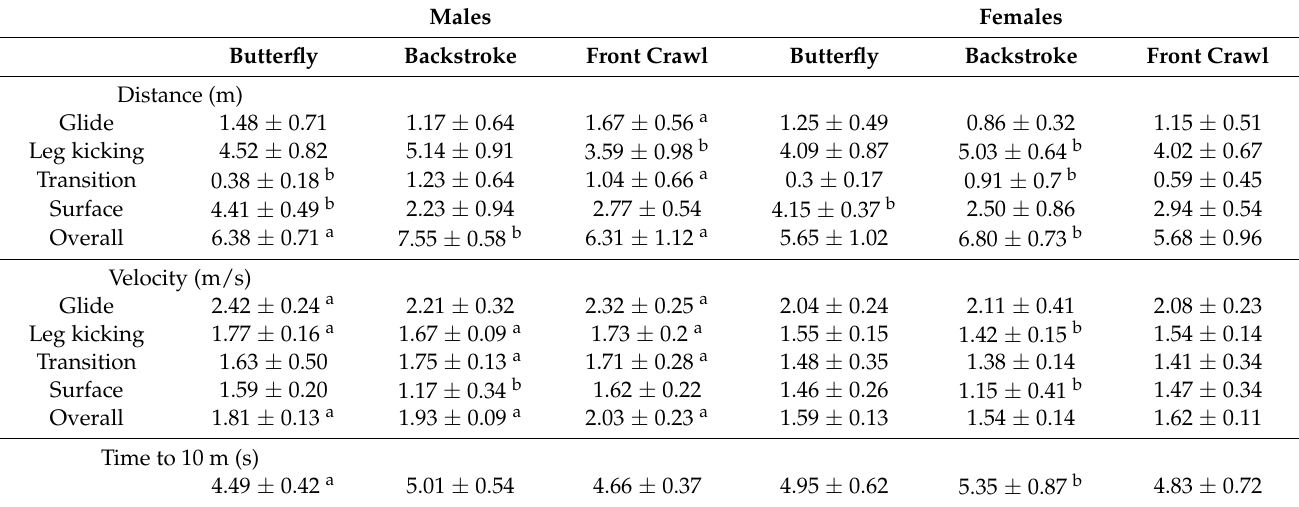
Table 1. Kinematic parameters of the competitive swimmers on the different phases of the push start. Males Females Butterfly Backstroke Front Crawl Butterfly Backstroke Front